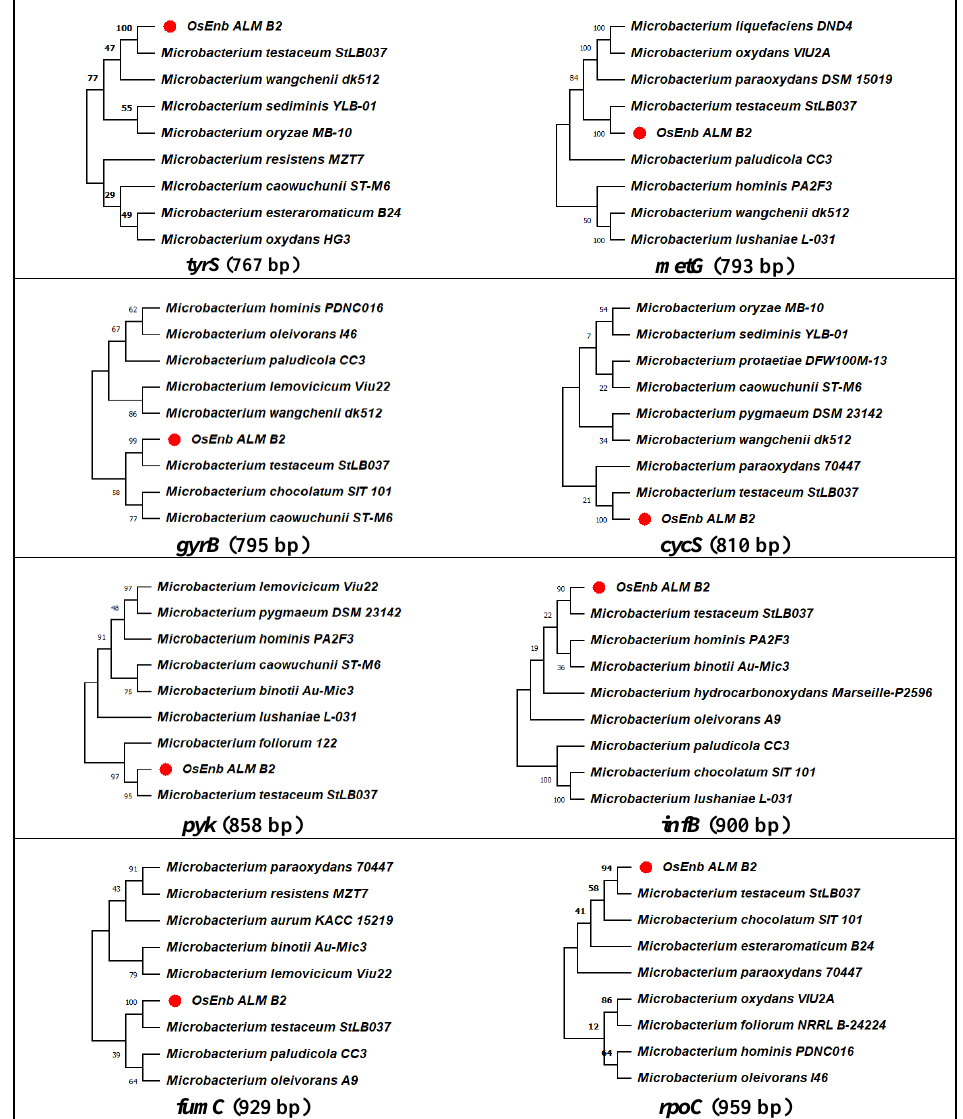
Figure 1. Molecular phylogenetic analysis of Microbacterium species by maximum likelihood method. The evolutionary history was inferred using the Maximum Likelihood method and the Hasegawa–Kishino–Yano model. The % of trees in which the associated taxa clustered together is shown above the branches. This analysis involved the nucleotide sequence of nine isolates. Evolutionary analyses were conducted in MEGA11.